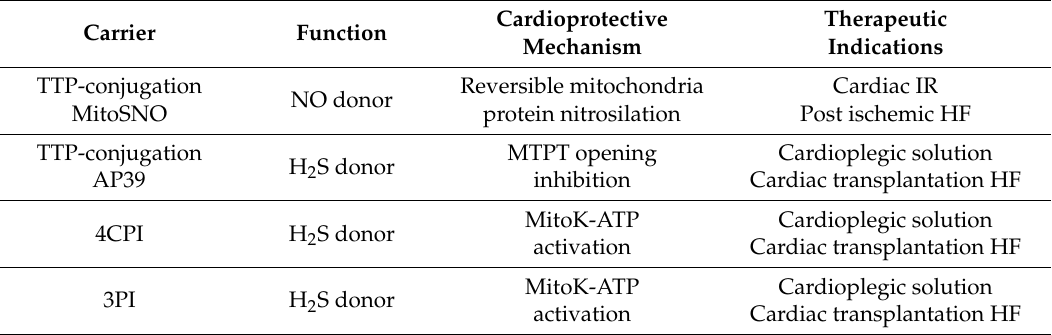
Table 2. Mitochondrial delivery of cardioprotective NO and H 2 S donors and putative best therapeutic indications to be explored in